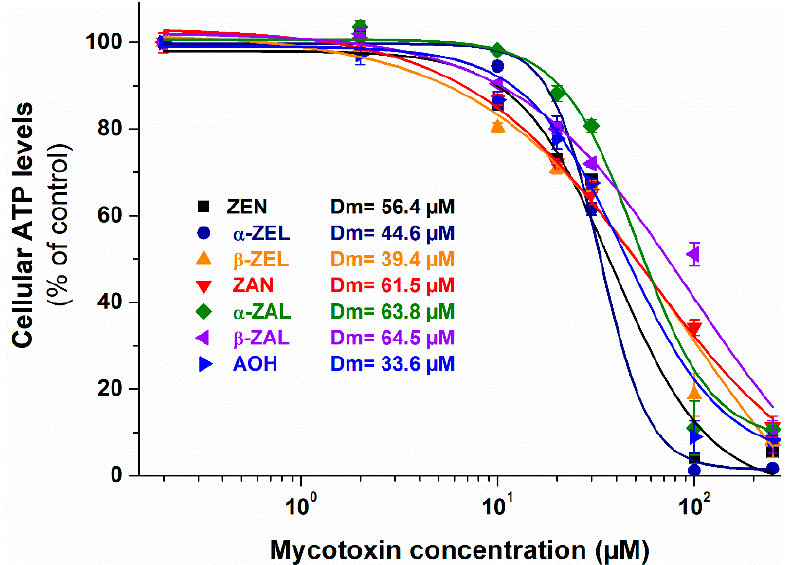
Figure 2. The effects of ZEN, α -ZEL, β -ZEL, ZAN, α -ZAL, β -ZAL, and AOH on the viability of HeLa cells (ATP/well, % of control) after 24 h incubation. Statistically significant ( p < 0.01) decreases in cell viability were noticed at (and above) the following mycotoxin concentrations: 10 µM for AOH, ZEN, ZAN, β -ZEL, and β -ZAL; and 20 µM for α -ZEL and α -ZAL.